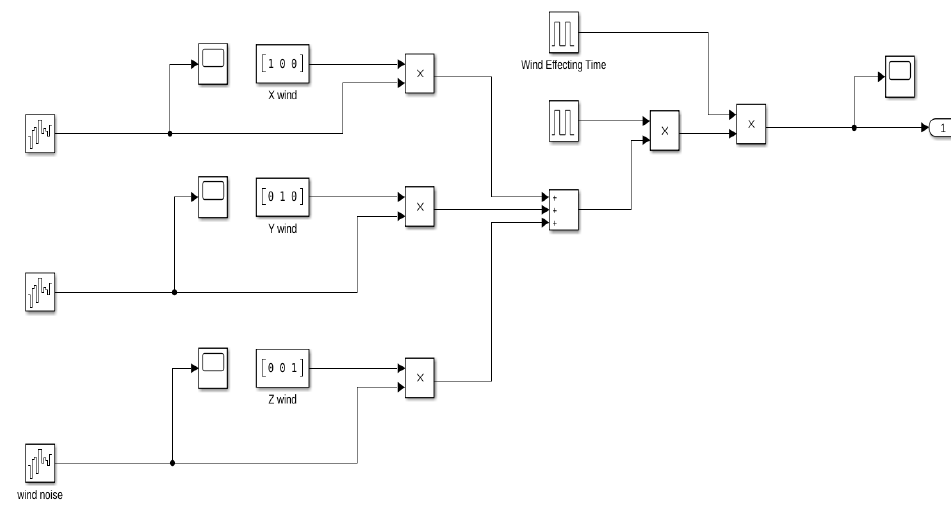
Figure 12. Wind Figure 12. Wind noise.